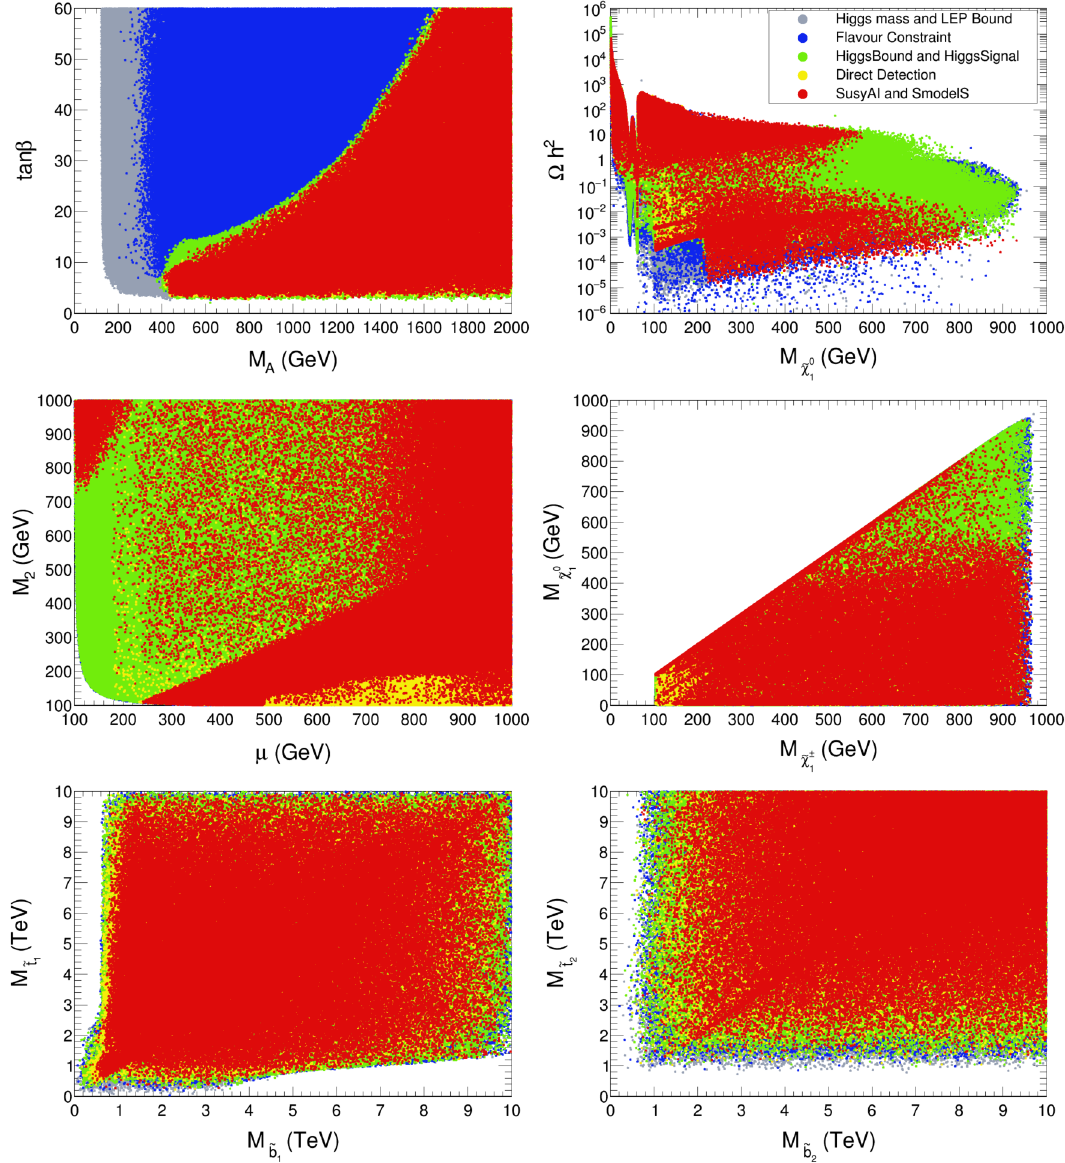
Figure 24. Scatter plots in the plane of various MSSM parameters and